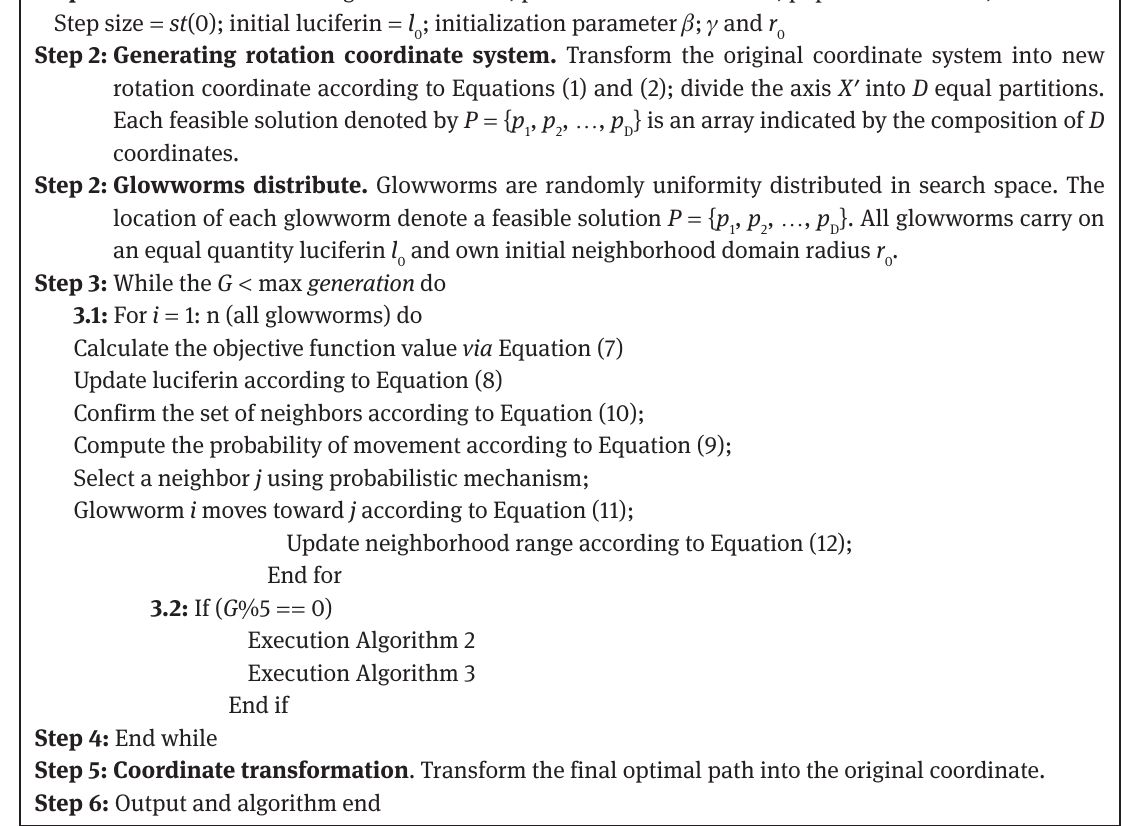
Algorithm 5. PGSO for Solving UCAV Path-Planning Algorithm.